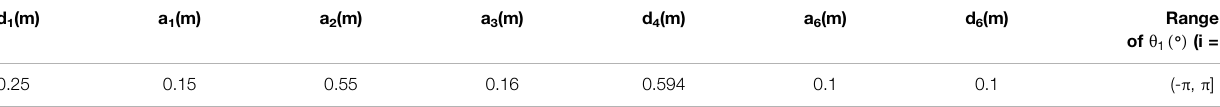
TABLE 1 | Values of relevant parameters of general industrial six-degree-of-freedom robotic arms and the range of values of each joint angle.